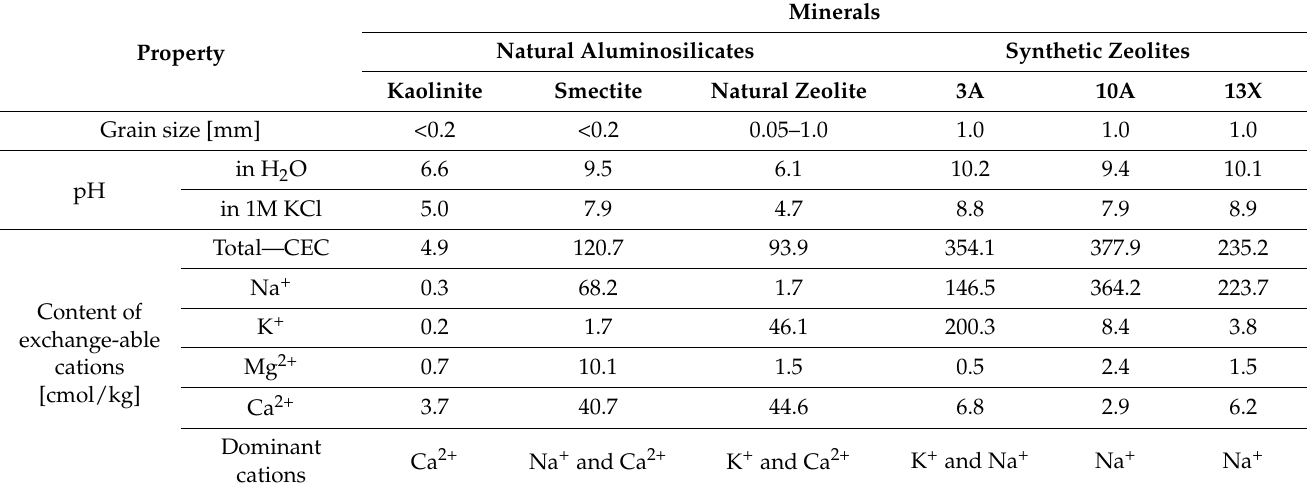
Table 1. The key properties of minerals used in the